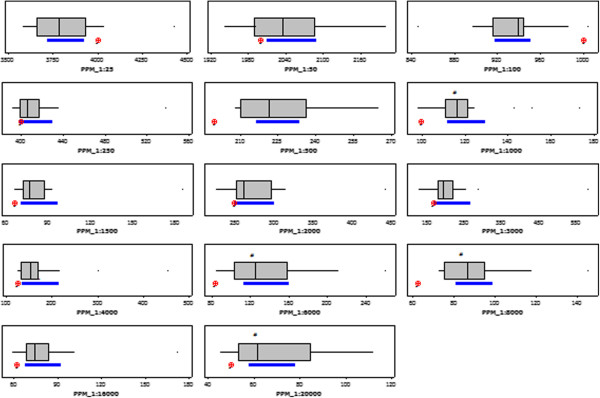
Test dilutions t-test boxplots. Expected PPM (red dot), 95% confidence interval from PPM results (blue line). The asterisk (*) indicates outliers while hash (#) indicates dilutions producing a significant different PPM than expected.